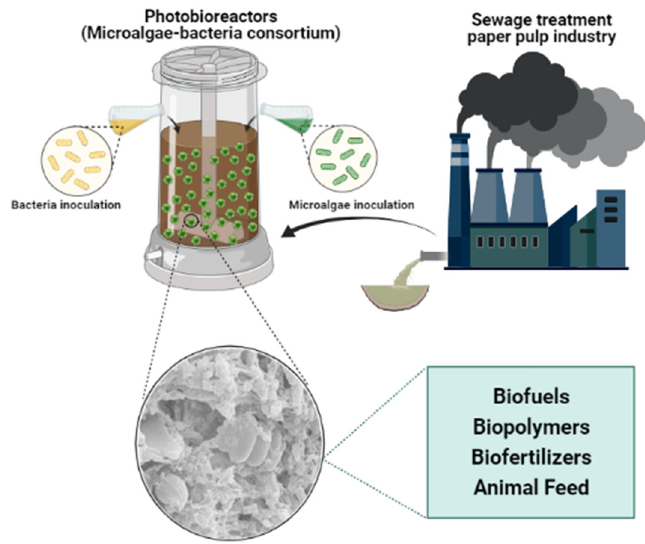
Figure 1. Schematic representation of the experimental setup.